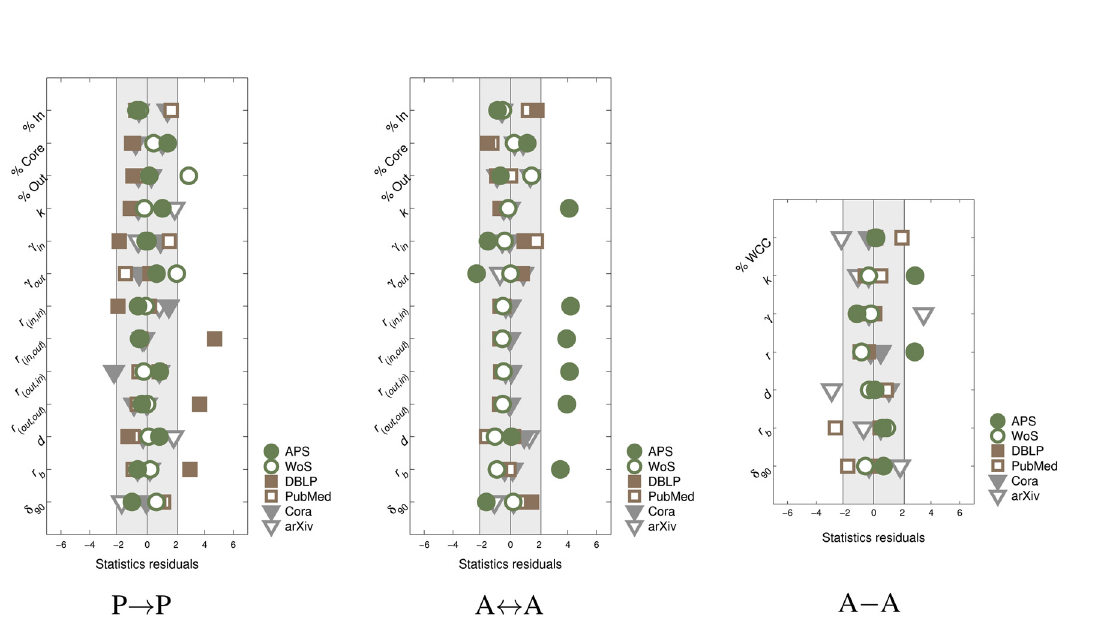
Fig 3. Analysis via residual computation. Externally studentized residuals for all databases, computed separately for each independent network measure and each network category. See Methods for interpretation and details on computation.